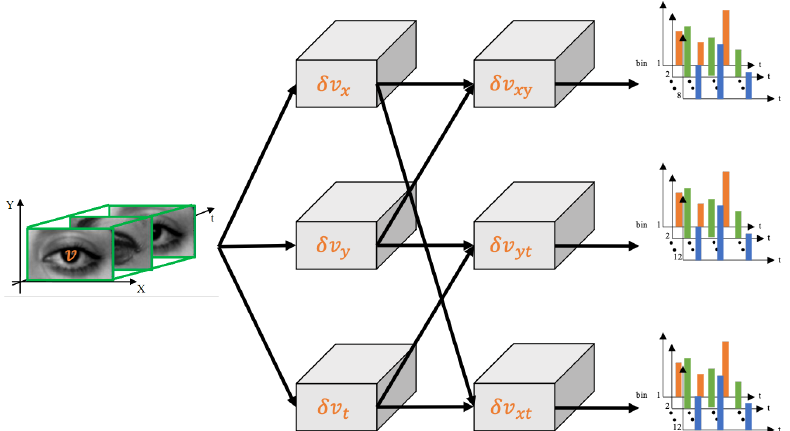
Figure 3. Conceptual summary of the descriptor extraction process for a facial cube using 3DHOG.